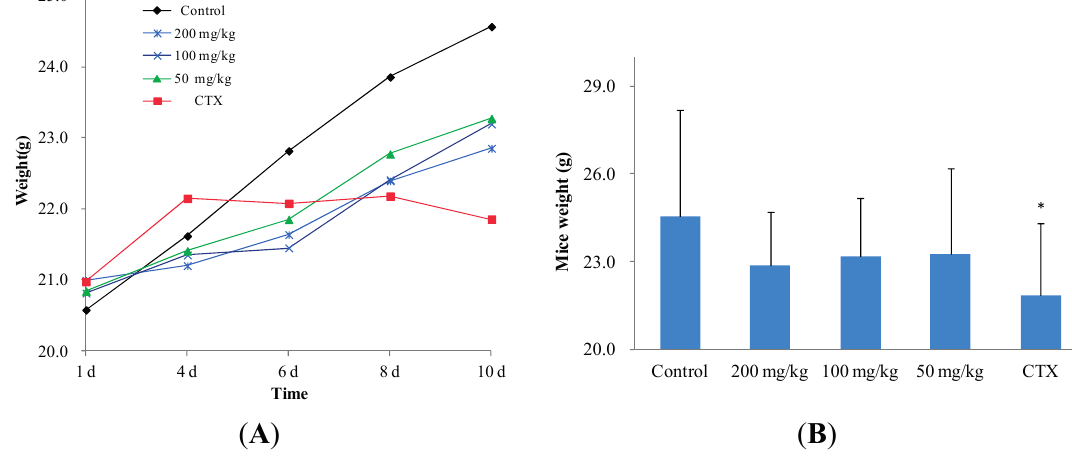
Figure 4. Influence of 8-acetamino-isocorydine ( 11 ) on body weight of mice bearing murine hepatoma H . ( A ) The trend of weight increase during the treatment period with 22 11 . The body weights increased in the blank control and treatment groups, but decreased in the CTX group; ( B ) Body weight of all groups at 10 d. The body weight of the blank control group and treatment groups were significantly different from that of the CTX group (* p < 0.05). There was no significant difference between the blank control group and treatment